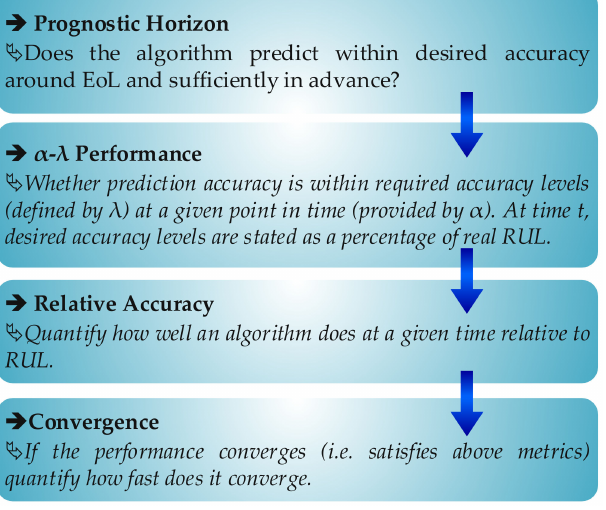
Figure 8. Prognostics metrics. Reproduced from [2], PHM Society and from [4],